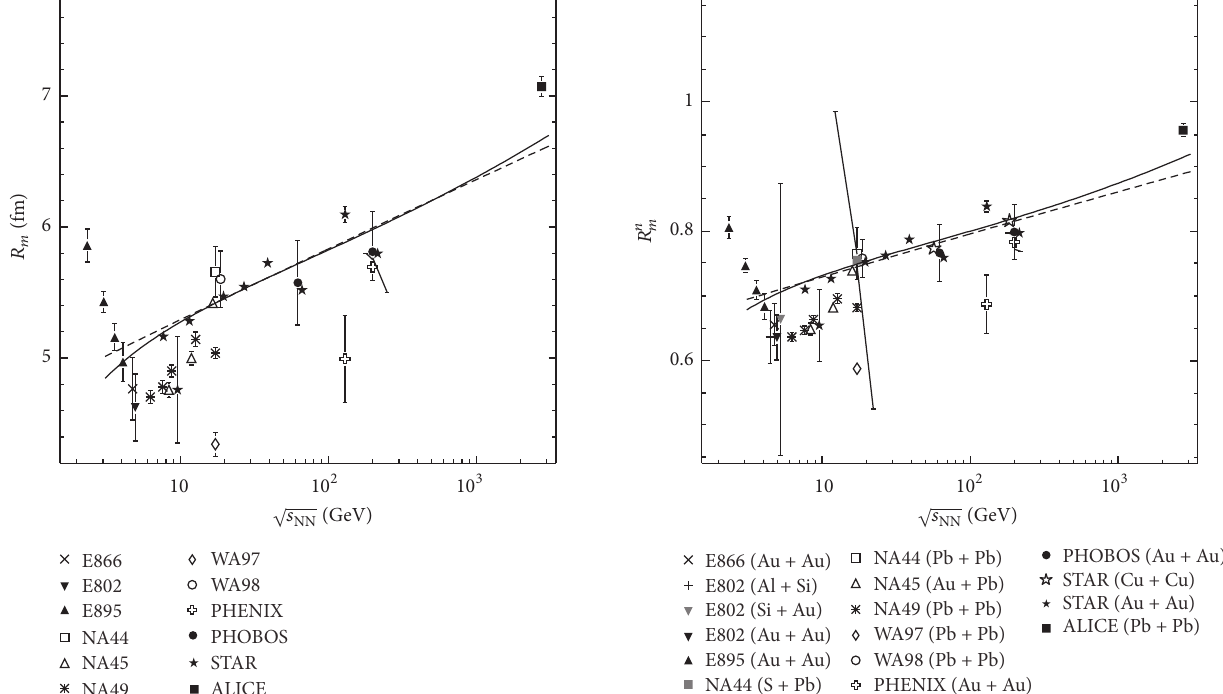
Figure 4: Energy dependence of scaled 𝑅 𝑛 𝑚 for secondary charged pions in various nucleus-nucleus collisions at ⟨𝑘 ⊥ ⟩ ≃ 0.2 GeV/ 𝑐 . Experimental results are shown for central collisions (for minimum- bias event in the case of E802 for Al + Si), for pairs of 𝜋 − mesons (in the cases of ALICE and STAR for both the Cu + Cu and Au + = 7.7 – 62.4 and 200 GeV, for 𝜋 ± 𝜋 ± pairs, E802 for Al + Au at √𝑠 NN Si and NA44 for 𝑆 + Pb, for pairs of 𝜋 + mesons) and for standard Coulomb correction 𝑃 (1) 𝐶 (𝑞) (in the cases of ALICE, NA44, NA45, = PHOBOS, and STAR for both the Cu + Cu and Au + Au at √𝑠 NN 7.7, 11.5 – 62.4 ,and200 GeV,forcorrection 𝑃 (3) 𝐶 ).Statisticalerrorsare shown (for NA44, total uncertainties). Smooth curves are derived from fit results for scaled BEC radii [15]. The solid line corresponds to the fits of scaled BEC radii by function (7) and dashed line to the fits by specific case ∀𝑖 = 𝑠,𝑜, 𝑙 : 𝑅 𝑛 𝑖 ∝ ln 𝜀